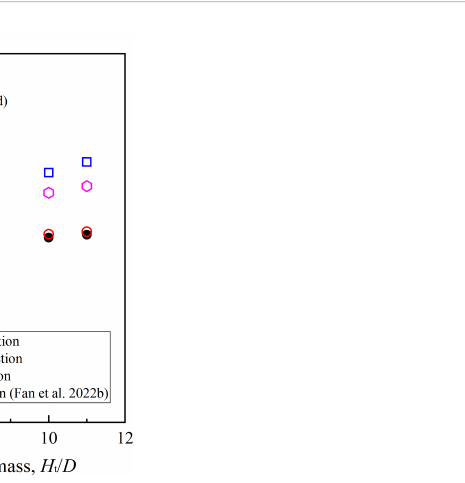
FIGURE 7 Deviation coef fi cients of the horizontal peak impact forces versus normalized thicknesses of the slide